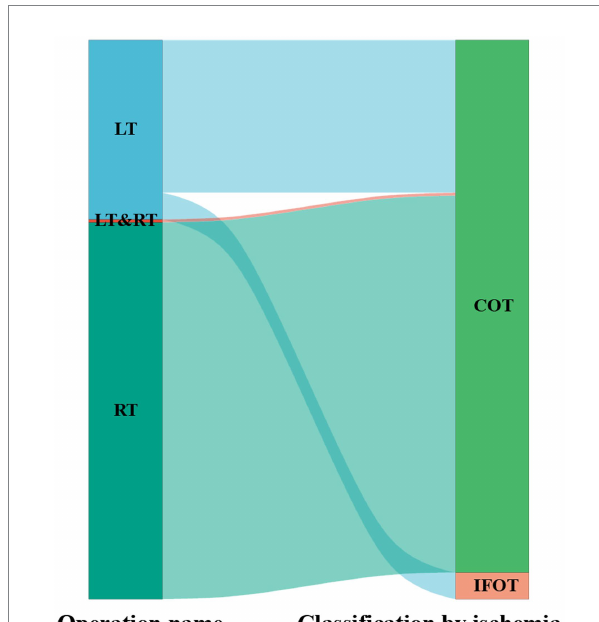
FIGURE 2 Sankey diagram depicting the selection of surgical methods in a tertiary hospital from July 2017 to December 2019. LT, liver transplant. RT, renal transplant. COT, conventional organ transplant. IFOT, ischemia-free organ transplant.